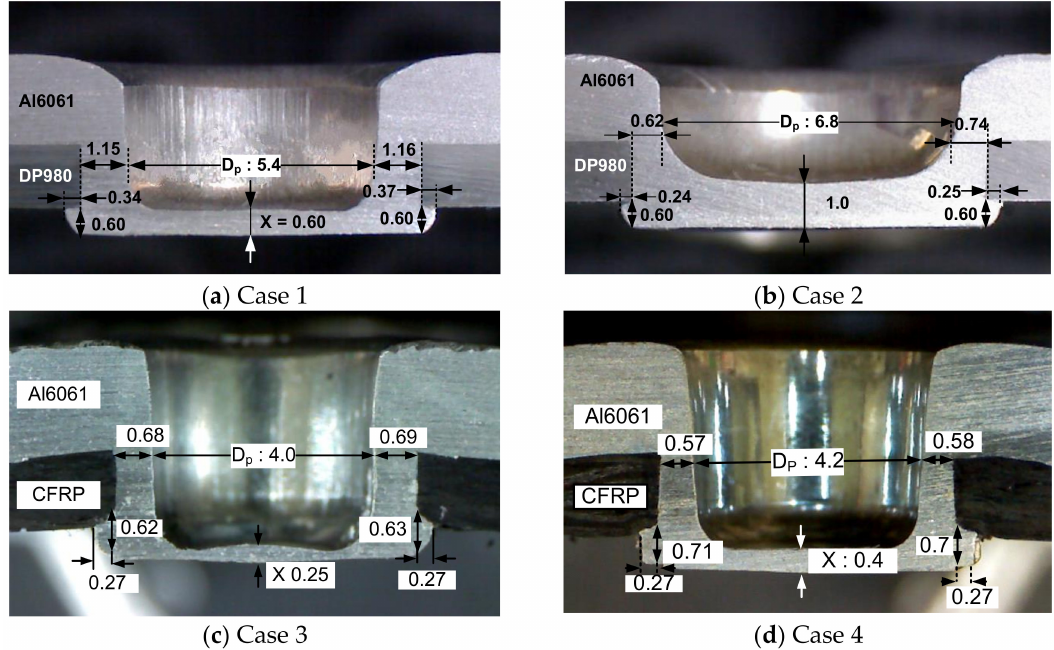
Figure 4. Geometrical interlocking parameters of hole-clinched